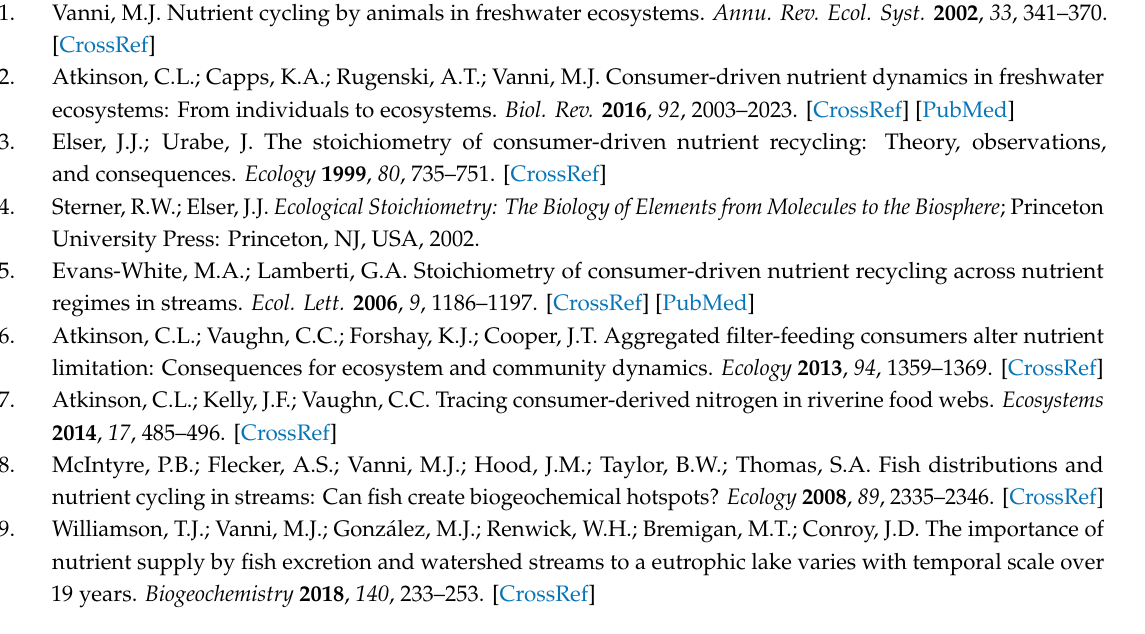
Figure S1: Scatterplots of mean log-transformed N and P excretion and egestion rates and individual body dry mass across all study populations included in the meta-analysis. Panels are arranged into (a) N egestion and dissolved inorganic N (DIN) excretion, (b) N egestion and total N (TN) excretion, (c) P egestion and dissolved inorganic P (DIP) excretion, and (d) P egestion and total P (TP) excretion. Equations next to legend identifications describe linear regression statistics for each pathway of nutrient release as a function of body mass. Only populations from which both excretion and egestion were measured are included, Figure S2: Scatterplots of (a) N release ratios, (b) P release ratios, or (c) N:P release ratios of egestion relative to excretion across degrees of consumer-resource elemental imbalance. Pearson’s correlation coe ffi cients and p -values are designated for each dataset (all phyla included) within each panel, Table S1: Summary of best-fit mixed e ff ects model intercepts for all analyses of release ratios, Table S2: Summary of best-fit mixed e ff ects model intercepts for all analyses of release relative variance. Author Contributions: Conceptualization, H.M.H. and C.L.A.; Methodology, H.M.H. and C.L.A.; Investigation, H.M.H. and C.L.A.; Formal Analysis, H.M.H.; Writing, H.M.H. and